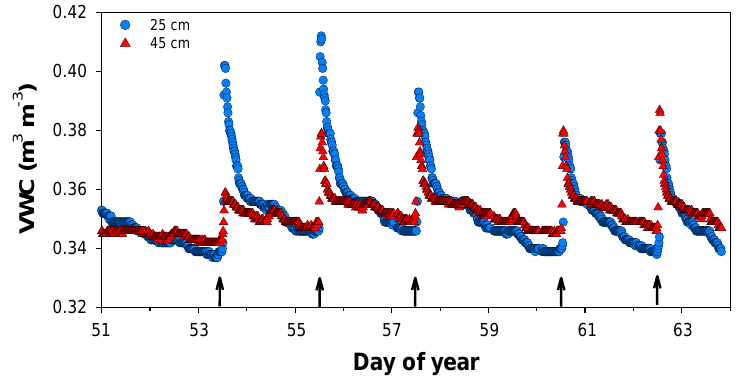
Figure 11. Evolution of VWC sensors at 25 and 45 cm depth measured by node 04 with 10HS sensors (year 2020). The arrows indicate the irrigation events.